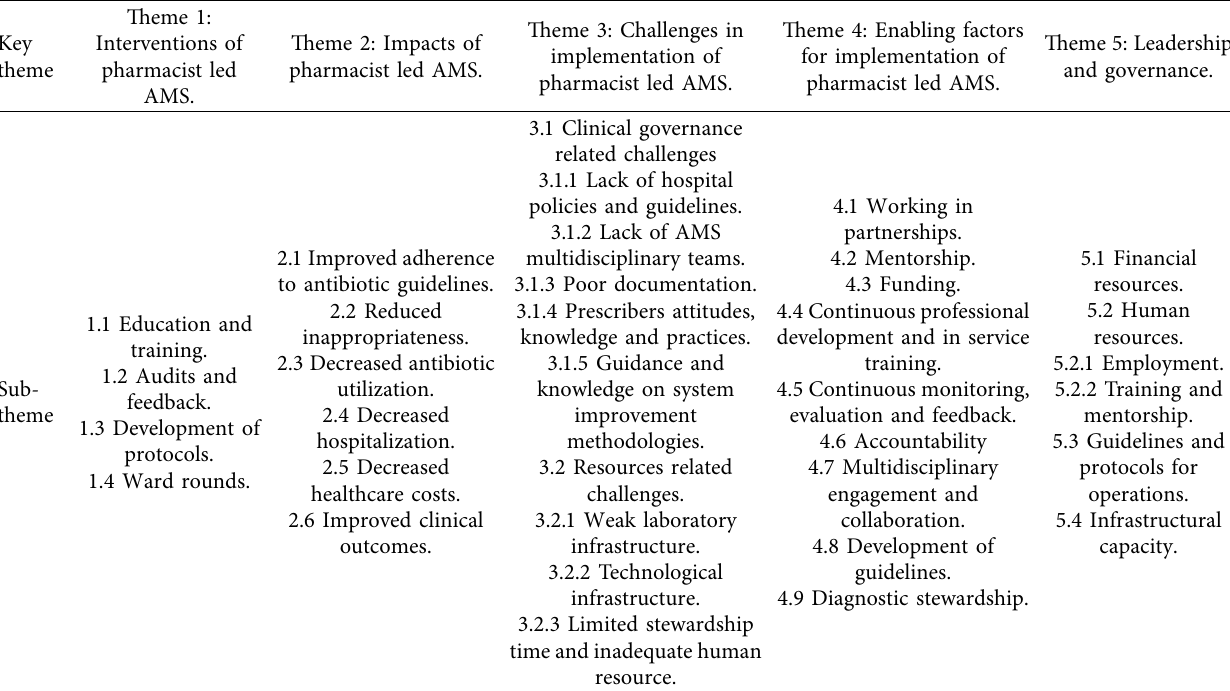
Table 3: Key themes and